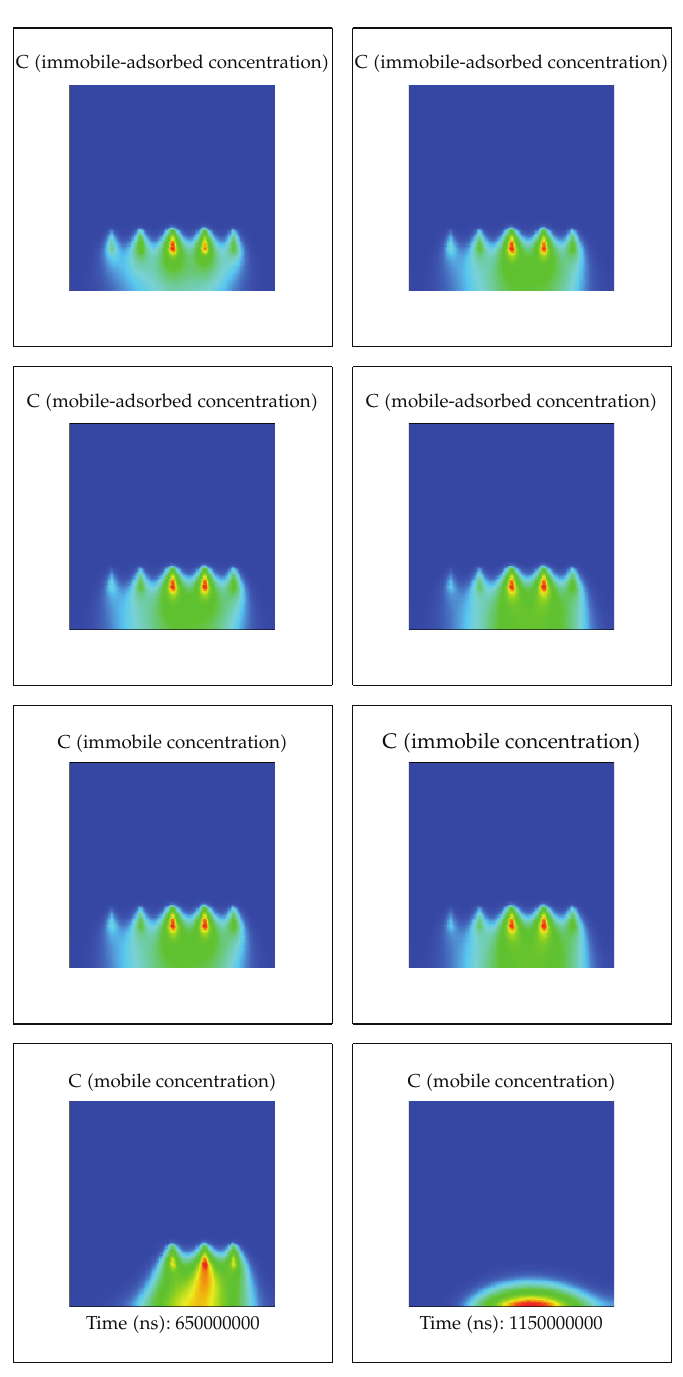
Figure 10: mobile (cid:2) lowermost (cid:3) , immobile (cid:2) lower-middle (cid:3) , mobile-adsorbed (cid:2) upper-middle (cid:3) and immo- bile-adsorbed (cid:2) uppermost (cid:3) case of 11 moving sources moving with number of time step equal to 15 (cid:2) left figures (cid:3) and 25 (cid:2) right figures (cid:3) , where full concentration is given in red and zero concentration in